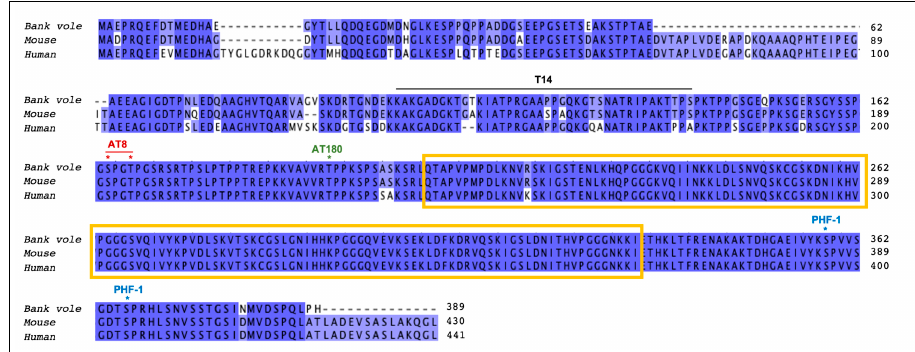
Figure 1. Alignment of bank vole, murine, and human Tau proteins. Colored boxes highlight highly conserved (dark blue), poorly conserved (light blue) and not conserved (white) residues. Yellow boxes indicate the microtubule binding region of Tau. For the alignment, the longest mouse Tau (430 amino acids) and human Tau (441 amino acids) isoforms were chosen. Epitopes recognized by the antibodies used in this study have been mapped on the aligned sequences using human Tau as reference.